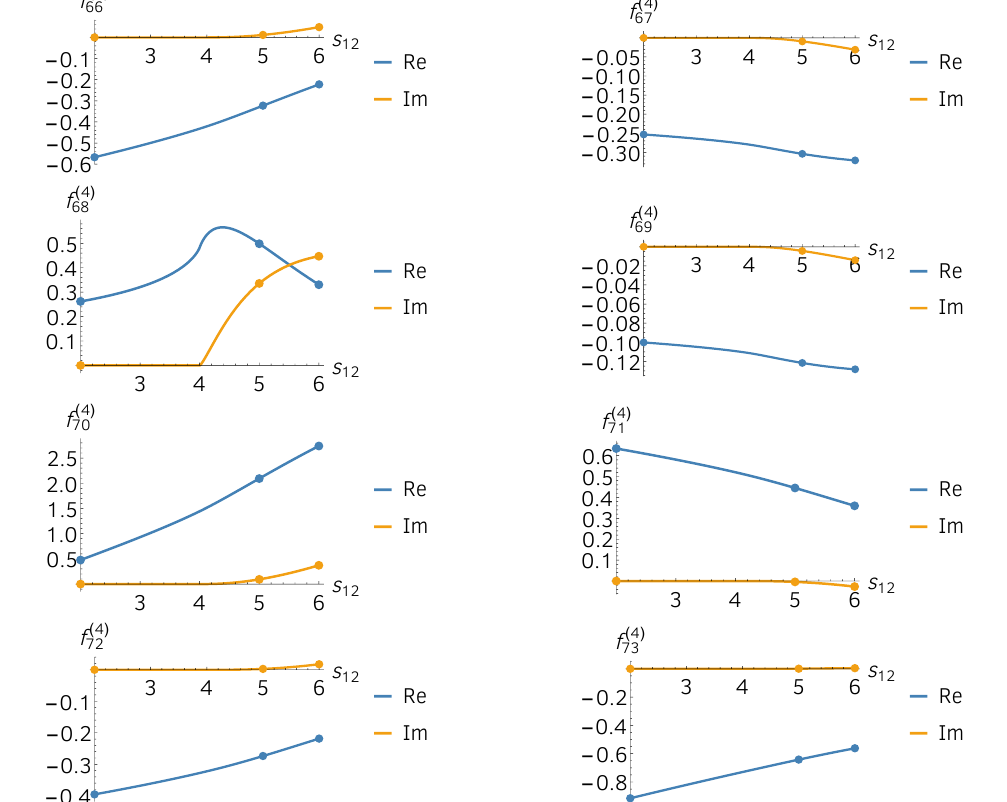
= 13 ; m 2 = 1 as a function of s 12 , 4 25